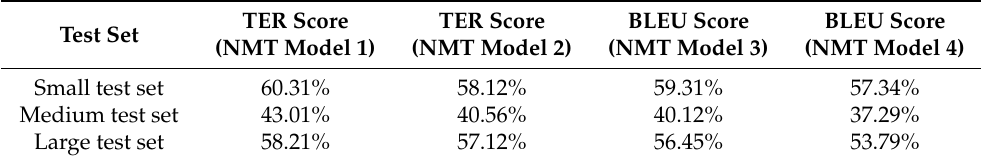
Table 14. TER score of the four NMT